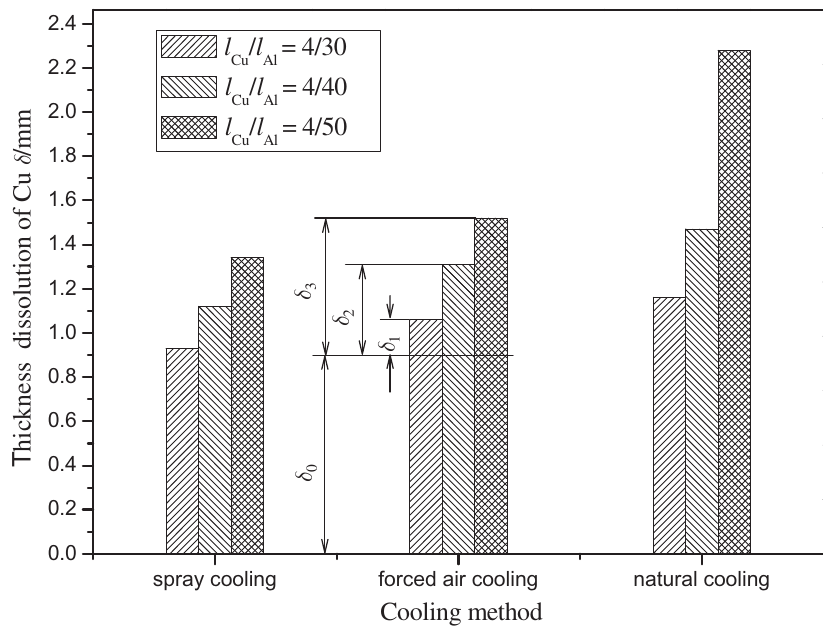
Figure 5: Average dissolved thickness of copper plate δ 0 – initial dissolved thick- ness; δ 1 , δ 2 , δ 3 – redissolved thickness after spray cooling, wind cooling and natural cooling.